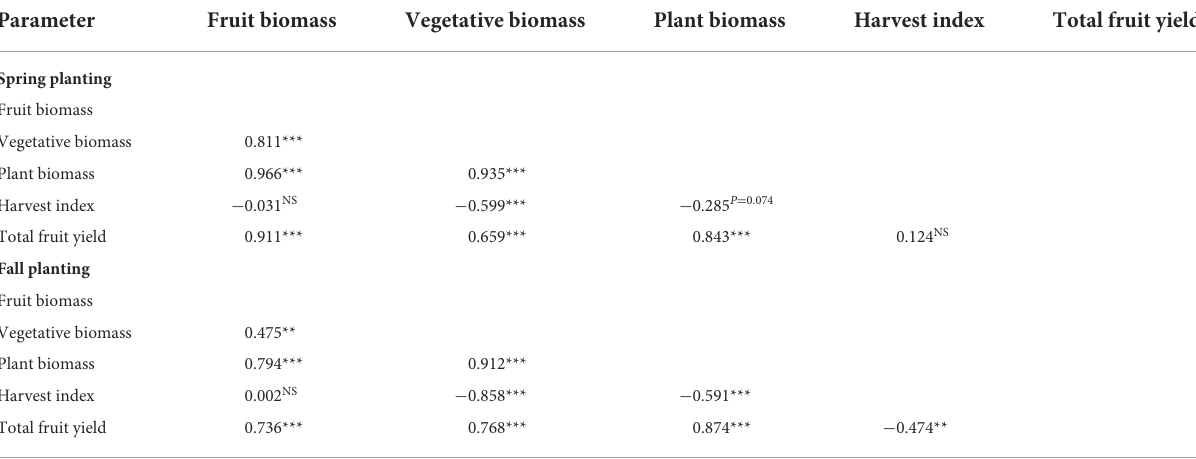
TABLE 6 Correlation coefficient values based on Pearson correlation analysis among fruit biomass, vegetative biomass, plant biomass, harvest index, and total fruit yield in the spring planting (14 February to 18 June 2020) and the fall planting (24 September 2020 to 15 April 2021). Parameter Fruit biomass Vegetative biomass Plant biomass Harvest index Total fruit yield